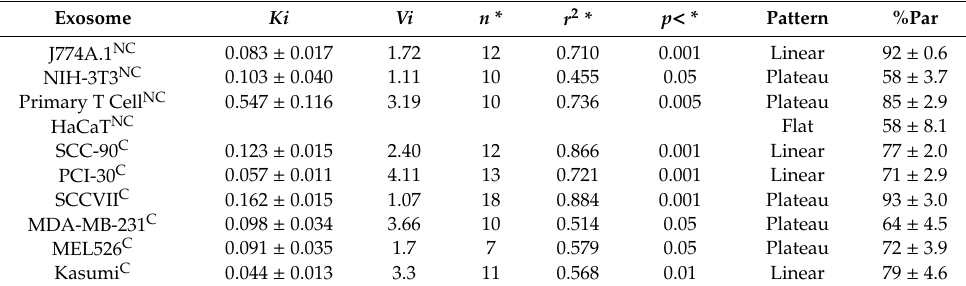
Figure 4. Examples of patterns for BBB passage and brain accumulation. Brain / serum ratios have been corrected for vascular space by subtracting albumin brain / serum ratios. Left upper panel illustrates continuous linear uptake of SCC-90 exosomes. Right upper and left lower panels illustrate a plateau pattern as seen with primary T cell-derived and SCCVII-derived exosomes. Only the HaCaT exosomes (right lower panel) did not show an increase in the brain / serum ratio with time. The closed circles represent data points describing the linear portion of the curve; the open circles represent data points that departed from linearity. See Table 3 for statistics. Table 3. Pharmacokinetics for Whole Brain Uptake a .